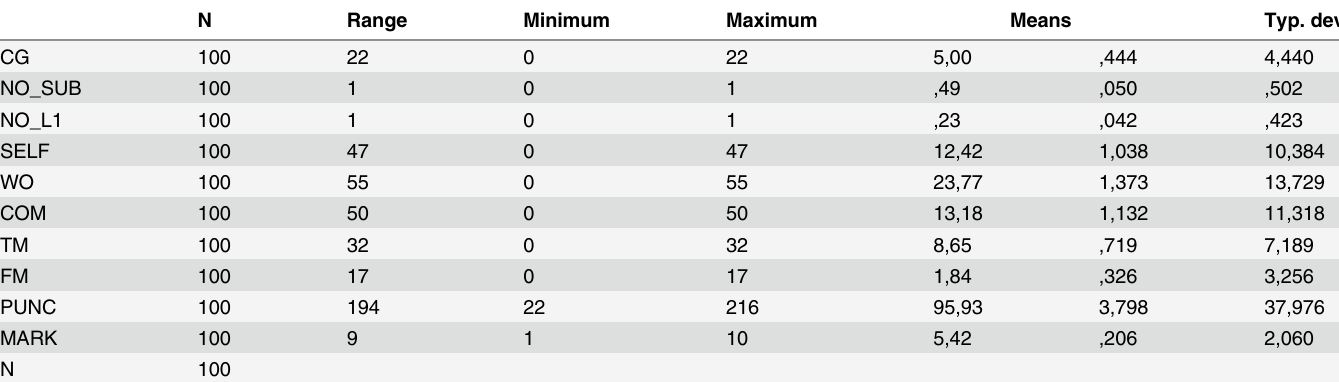
Table 3. Descriptive statistics in the written scripts.